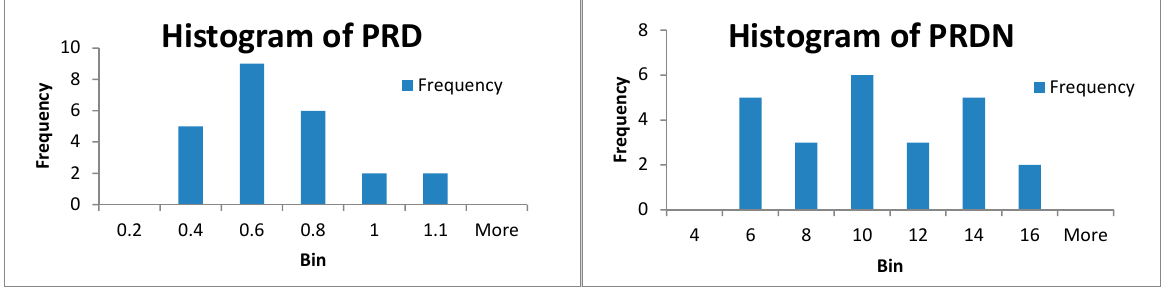
Figure 6. Histogram of PRD and PRDN for 24 ECG records for the CSCP method with a patient-specific dictionary with projection matrix by type of Gaussian distribution Random * Dict † .